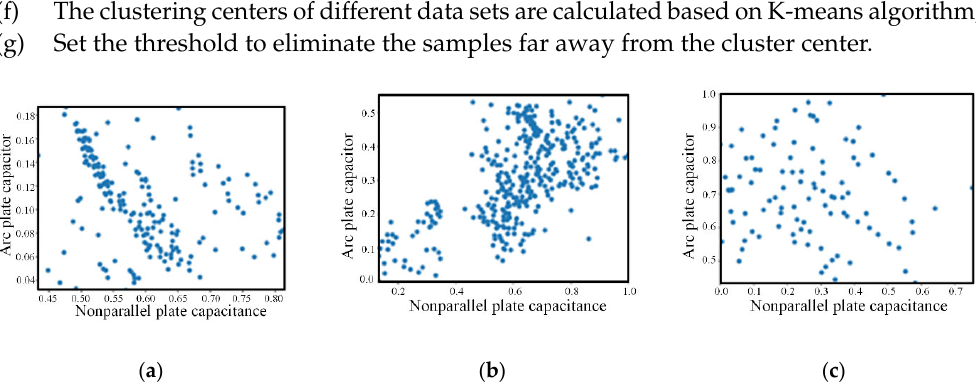
Figure 11. Initial data of three different types of wear capacitance. ( a ) cutting; ( b ) rolling; ( c ) sliding.